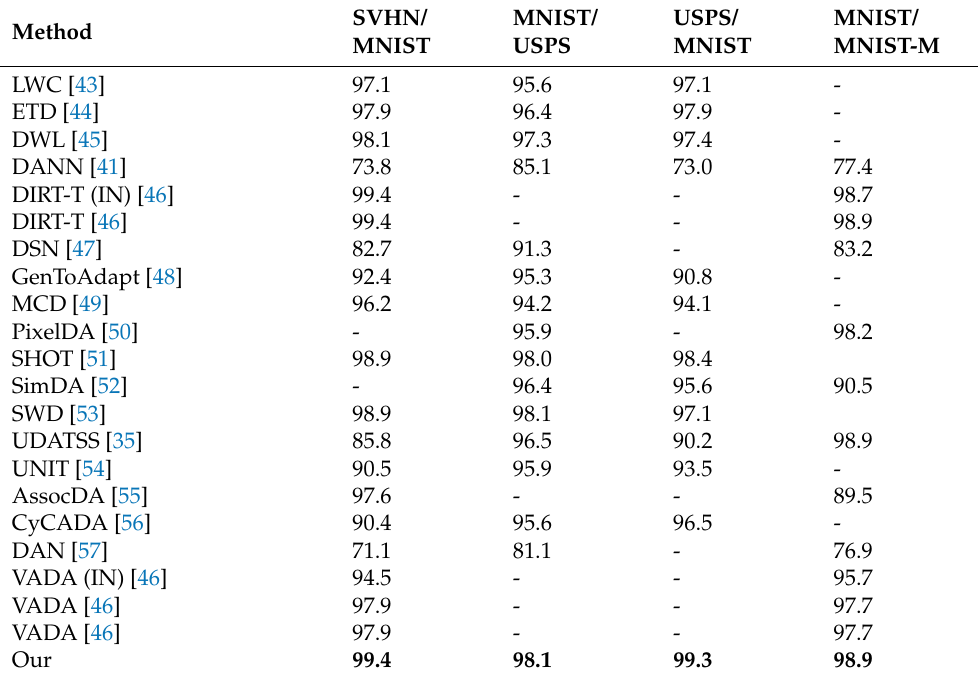
Table 5. Comparison of the proposed method with other methods.